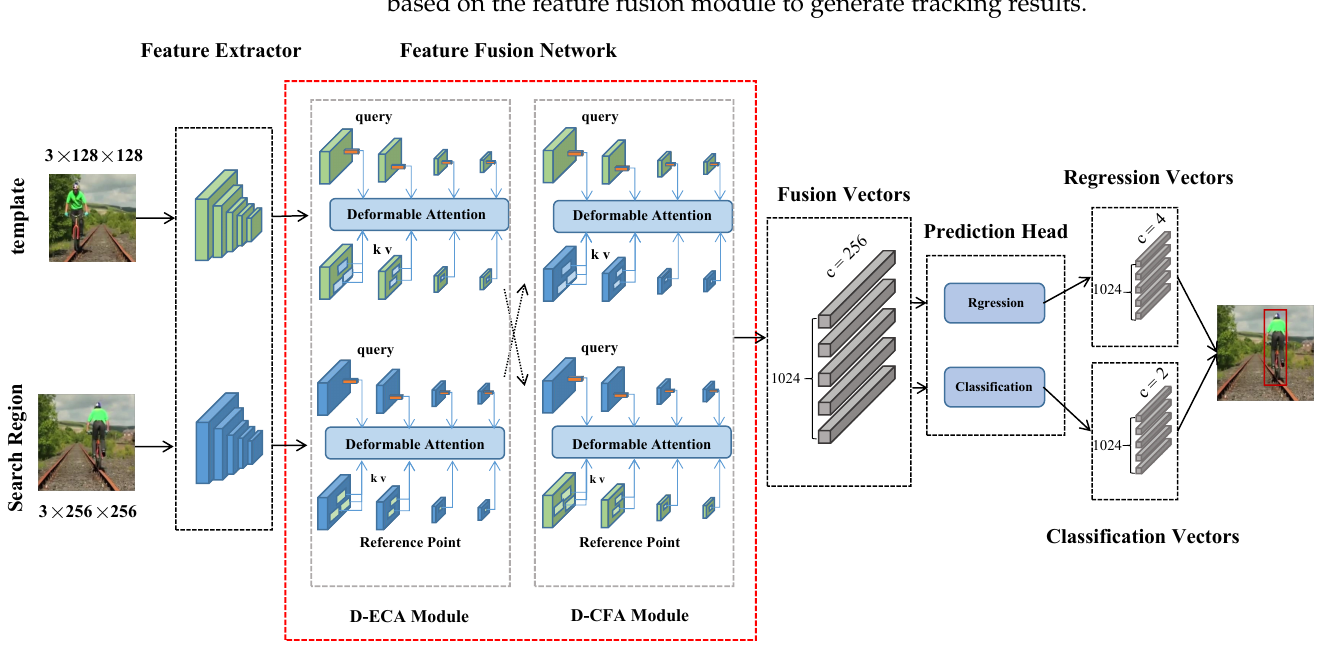
Figure 3. Architecture for Deformable Transformer Tracking. It consists of three parts: feature extraction, feature fusion, and prediction head. The deformable attention module pre-filters for influential key elements among all feature map pixels using a small set of sampling